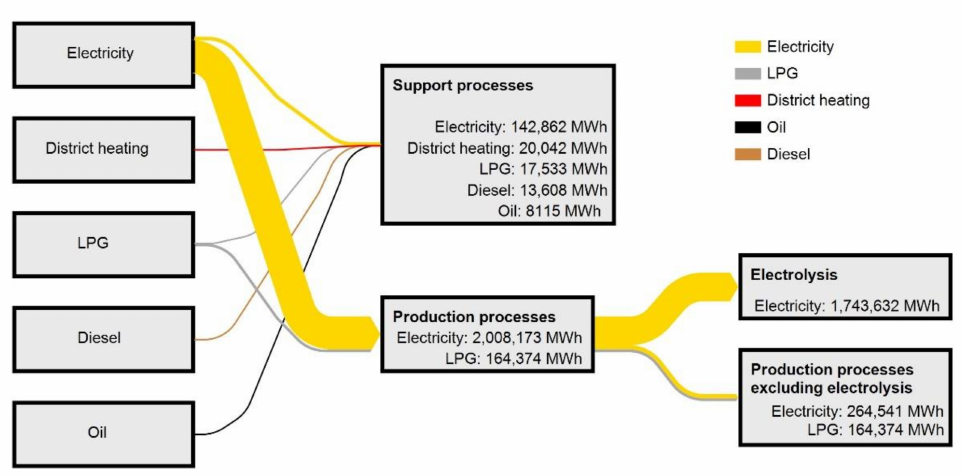
Figure 6. The energy end-use of the aluminium industry and two aluminium casting foundries in Sweden, divided into support and production processes. For production processes, the energy use for electrolysis is also shown.